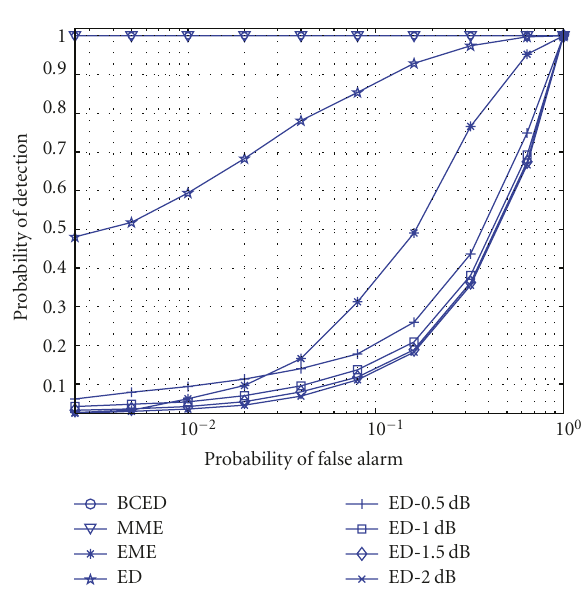
Figure 2: ROC curve: wireless microphone source